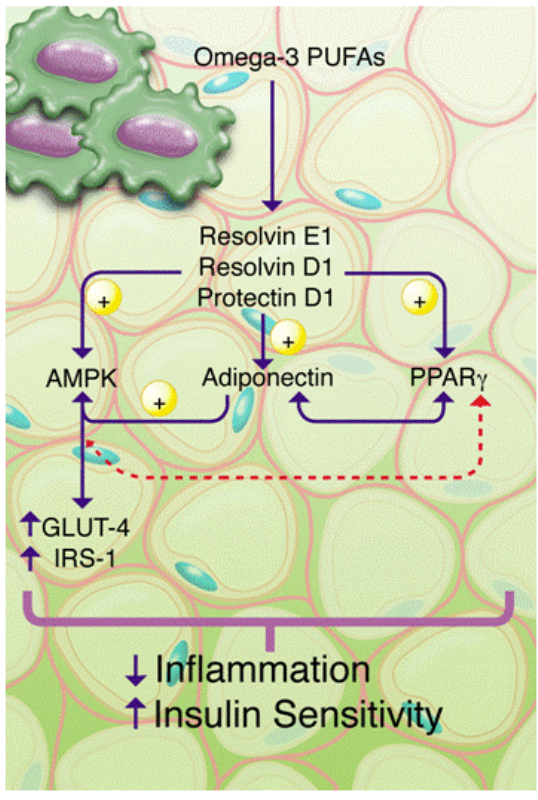
FIGURE 3. Anti-inflammatory and insulin-sensitizing effects of ω-3 PUFA–derived mediators in obese adipose tissue. The dietary intake of an ω-3 PUFA–enriched diet amplifies the formation of resolvins and protectins, which induce the secretion of adiponectin and up-regulate PPARγ expression and AMPK phosphorylation in the adipose tissue. Adiponectin is a potent antidiabetic and anti-inflammatory adipokine, whereas PPARγ  and AMPK act as gatekeepers of energy balance by regulating glucose and lipid homeostasis in adipose tissue. Interestingly, the effects of adiponectin appear to be mediated by a mechanism involving AMPK - dependent PPARγ  activation. Moreover, resolvins and protectins up-regulate genes coding for insulin receptor signaling (i.e., IRS-1, the substrate protein for